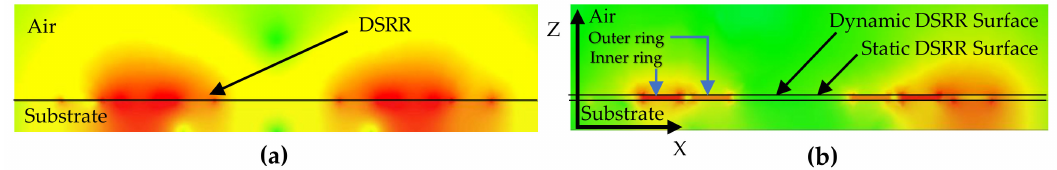
Figure 4. ( a ) Distribution of charges on SRRs in stacked resonator, ( b ) establishment of E / H fields equivalent to C s / L s.